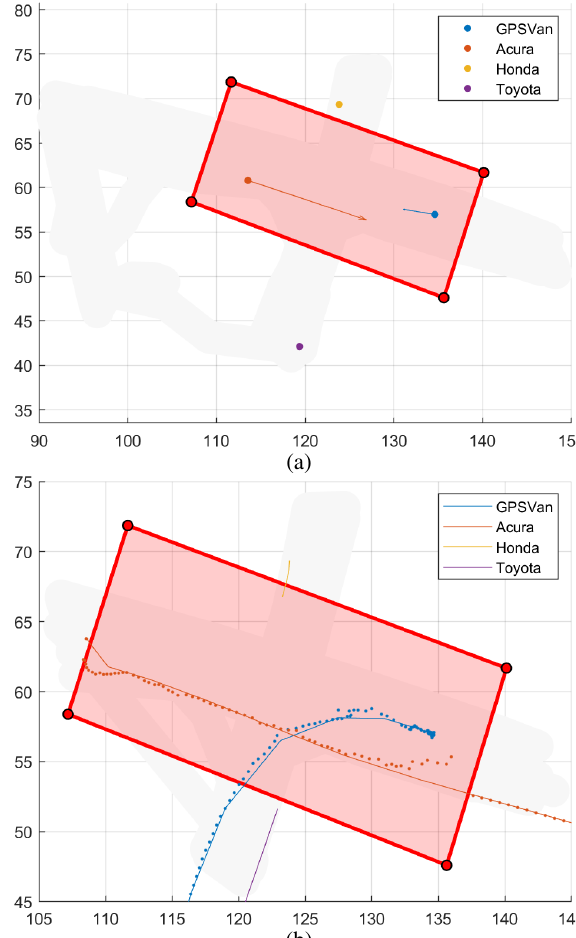
Figure 7. Case study 2: (a) vehicle starting configuration, (b) vehicle